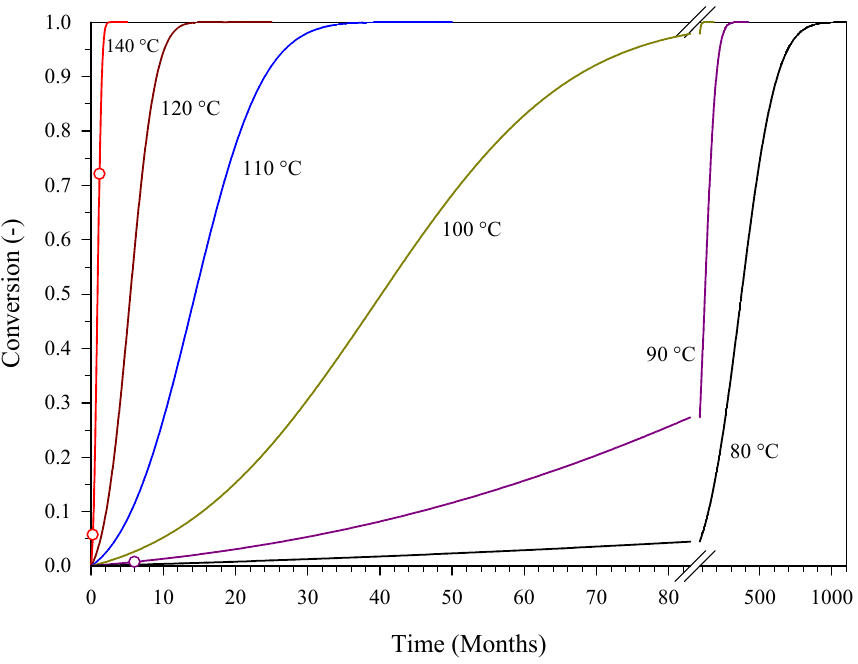
Figure 9. The conversion of PA versus time obtained via isothermal simulations performed with the kinetics from this study at different temperatures. Circles represent experimental data from accelerated aging tests.